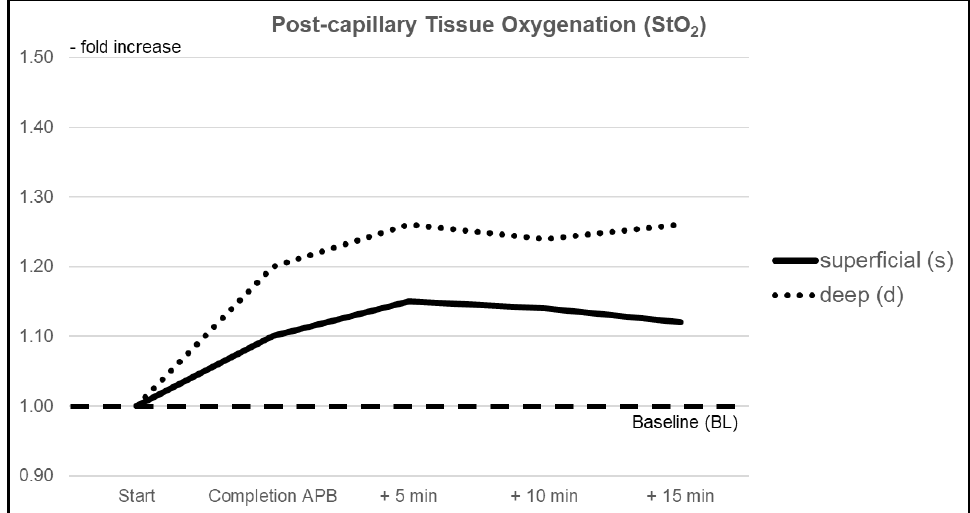
Figure 3. Relative changes in mean post-capillary oxygen saturation (StO 2 ) within superficial (pulp) and deep (thenar eminence) tissue layers over the duration of the investigation.